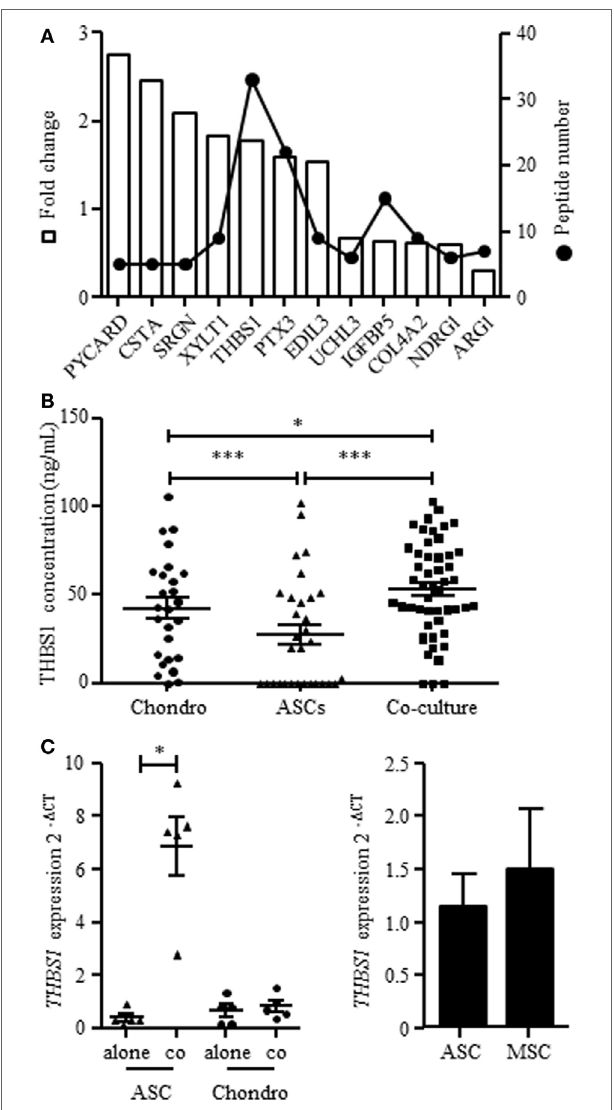
FigUre 1 | Expression of THBS1 in chondrocyte and adipose stem cell (ASC) mono- or cocultures. (a) Proteins identified in the secretome of chondrocyte/ASC cocultures significantly differentially secreted in chondrocyte/ASC cocultures as compared to mixed monocultures. The white bars represented the fold change of protein expression in coculture and the dot plot represented the number of quantified peptides for each proteins. Abbreviations: PYCARD , PYD and CARD domain containing; CSTA , cystatin A; SRGN , serglycin; XYLT1 , xylosyltransferase 1; THBS1 , thrombospondin-1; PTX3 , pentraxin-3; EDIL3 , EGF-like repeats and discoidin domains 3; UCHL3 , ubiquitin C-terminal hydrolase L3; IGFBP5 , insulin-like growth factor binding protein 5; COL4A2 , collagen type IV alpha 2; NDRG1 , N-Myc downstream regulated 1; ARG1 , arginase 1. (b) THBS1 protein was quantified in the supernatants of chondrocyte monocultures (Chondro), ASC monocultures (ASC) or cocultures by Enzyme-linked ImmunoSorbent Assay. Results are expressed as the mean concentration ± SEM ( n = 26–50 patient cell replicates). (c) THBS1 mRNA level was measured in ASCs and in chondrocytes, cultured alone or in cocultures by RT-qPCR. Results are expressed as relative gene expression (2 −Δ CT ) and represented as mean ± SEM ( n = 5 patient cell replicates). (D) THBS1 mRNA level was measured in BM-MSCs and ASCs by RT-qPCR ( n = 5). Statistics used unpaired t -test (b) or Mann–Whitney test (c,D) : * p ≤ 0.05, *** p ≤ 0.001.